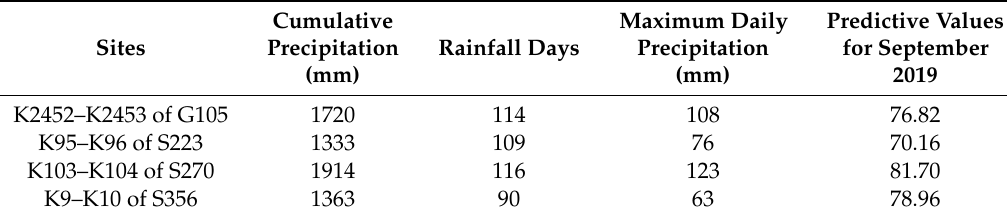
Table 5. Predicted SPI results for September